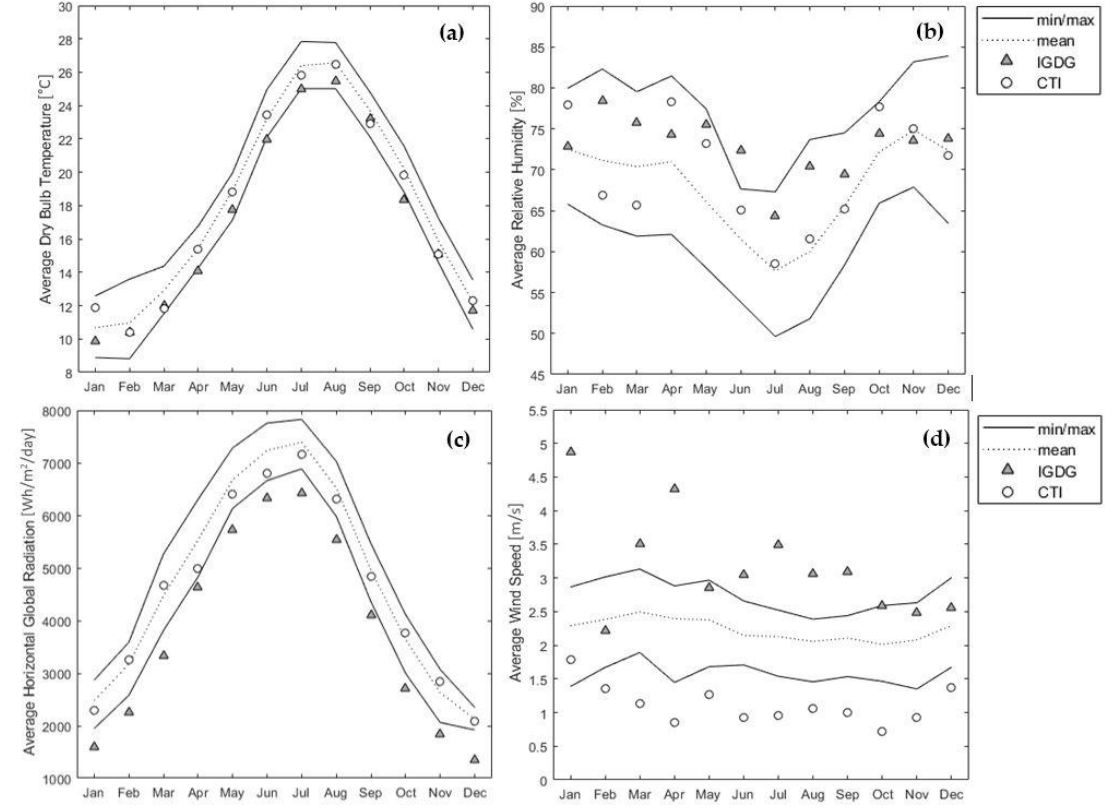
Figure 6. Average monthly values for the main weather data. The curves identify the range of variation for the single actual years. ( a ) Dry bulb temperature; ( b ) relative humidity; ( c ) daily global horizontal irradiation; ( d ) wind speed.